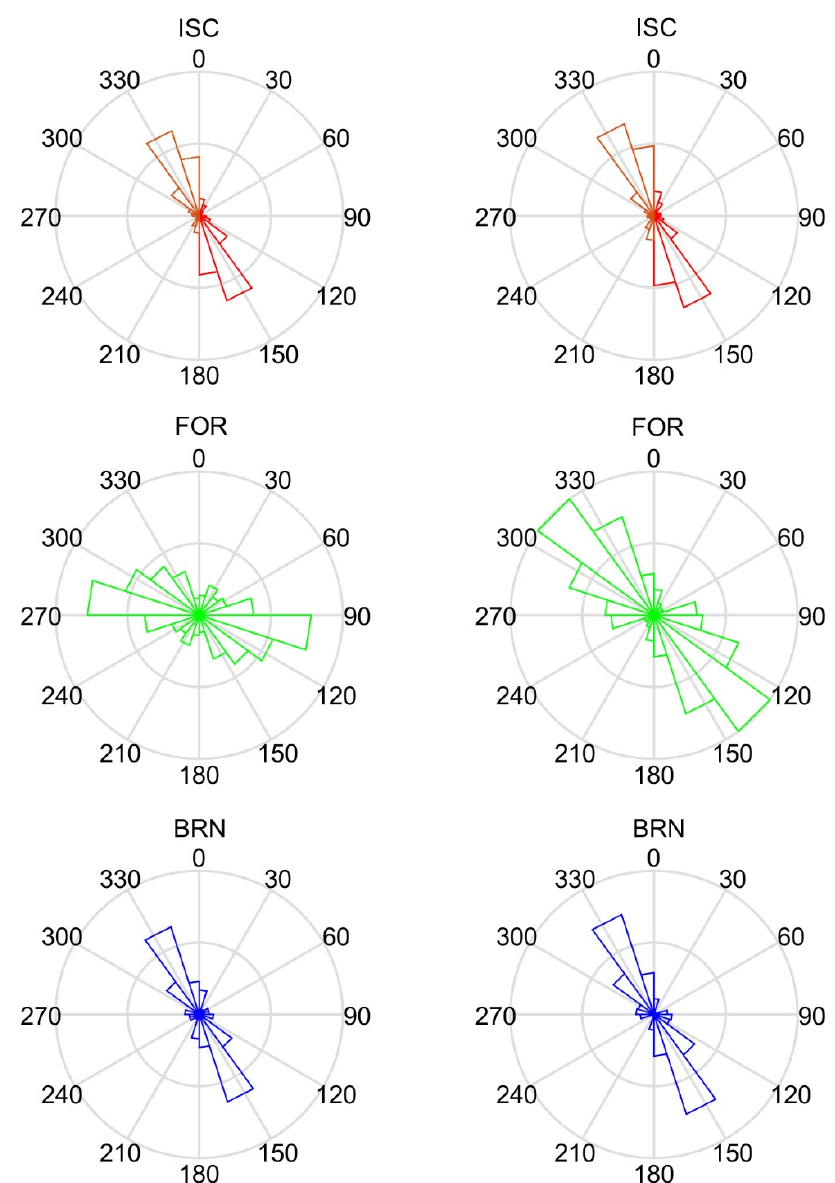
Figure 11. On the left , rose diagrams of the azimuths of the tilt signals corresponding to the Mm constituent (red = ISC, green = FOR, blue = BRN); on the right the same for the Mf constituent.